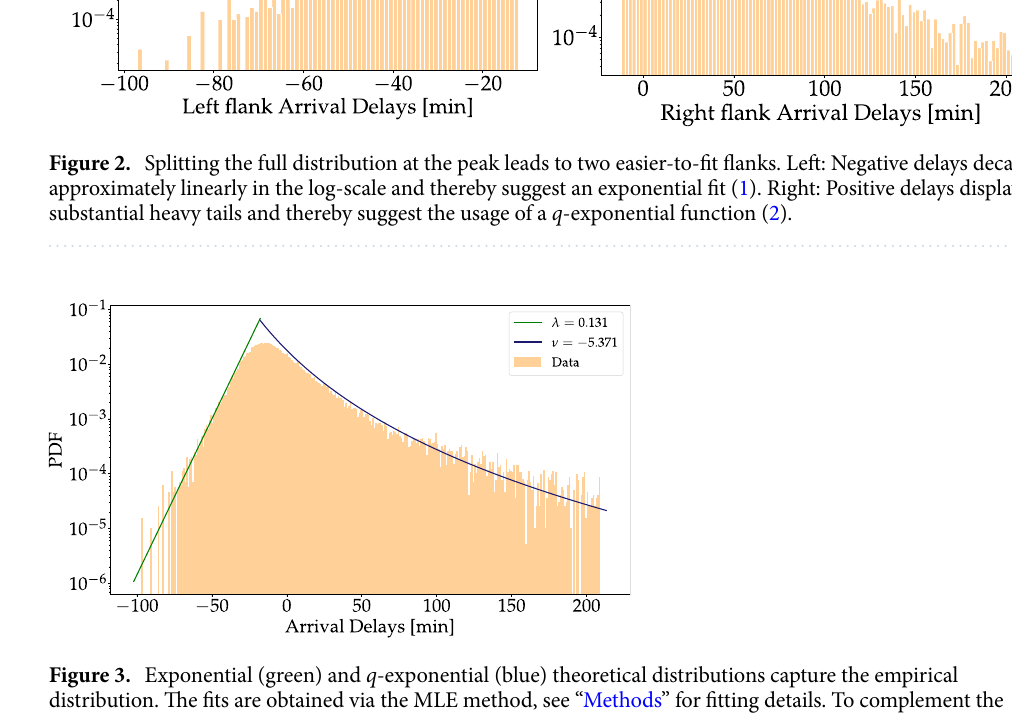
The left flank is observed to be well approximated by an exponential function of the form